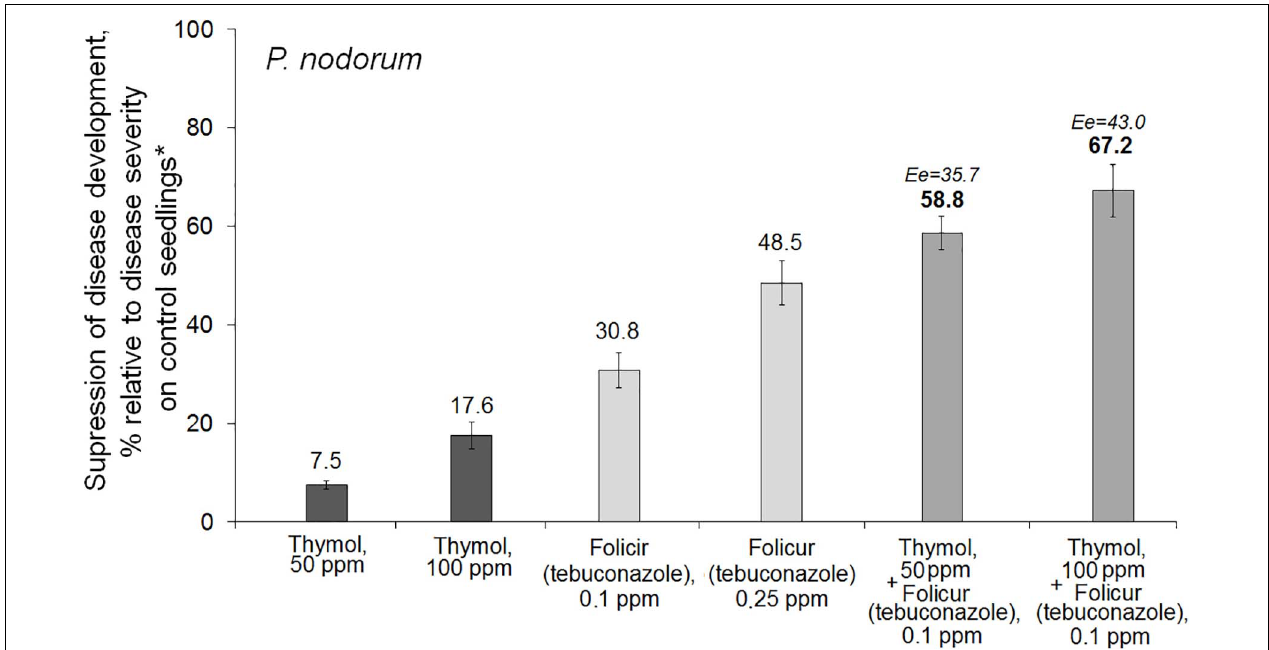
FIGURE 3 | Histograms showing the inhibitory effect of Folicur R (cid:13) EC 250 on development of Parastagonospora nodorum , a glume/leaf blotch agent, on wheat seedlings treated with thymol alone and the fungicide either alone or in two combinations with thymol. *The average percentage of disease development (100–120 seedlings per treatment); control plants were sprayed with P . nodorum conidia in water. The means of four experiments; Y-bars indicate SE (see section “Materials and Methods,” “Data Analysis and Statistics” and caption to Figure 1 for additional explanations).